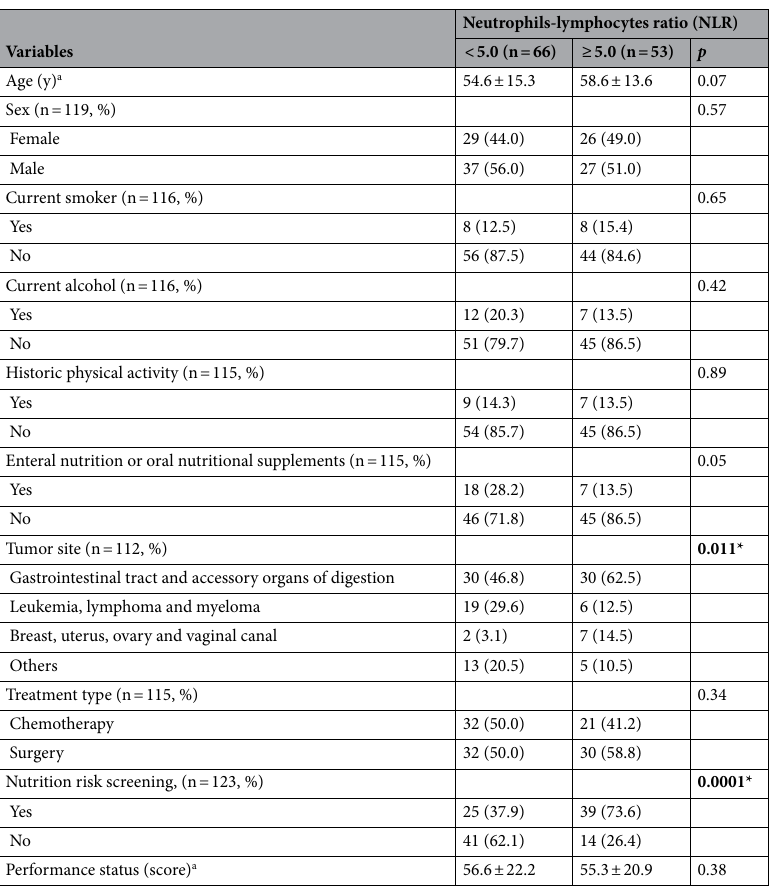
Table 1. Socio-demographic and clinical characteristics of the patients according to neutrophils-lymphocytes ratio. a Data are expressed as means ± standard deviation. * p < 0.05 was considered as